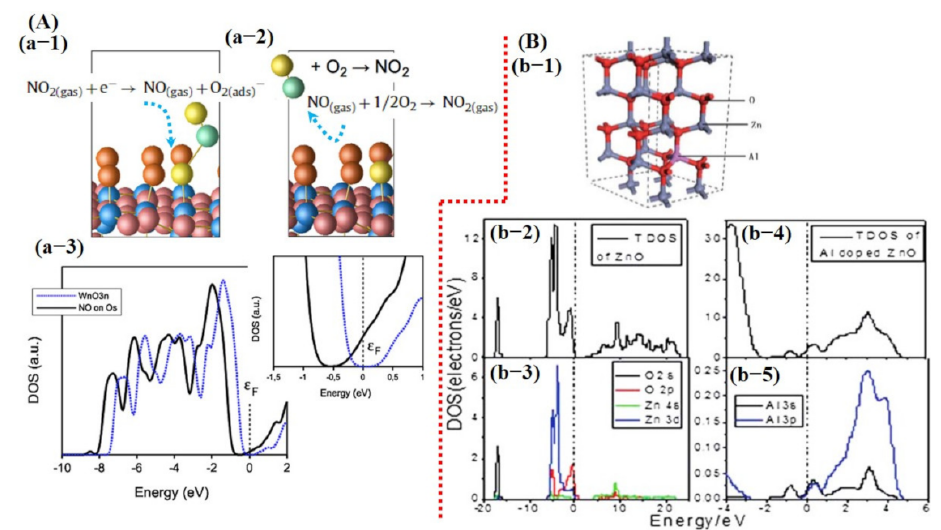
Figure 4. Computational study of metal oxide gas sensors: ( A ) NO 2 -sensing mechanism on WO 3 surface and DOS graph before and after exposure of NO 2 : (a-1) The dissociation of NO 2 molecule to NO when interacting with WO 3 surface while leaving behind oxygen adsorbent. (a-2) The formation of NO 2 from generated NO after reacting with one-half oxygen in the environment. This chain cycle significantly improves the oxygen adsorbent population consequently enhances the sensor response. (a-3) The DOS graph. A clear shift can be observed after NO exposure in the magnified image (reproduced with permission from [100], copyright 2014 Elsevier). ( B ) (b-1) A schematic image of Al-doped ZnO structure; (b-2) the change in Fermi energy level before and after Al doping in ZnO structure (reproduced with permission from [101], copyright 2013